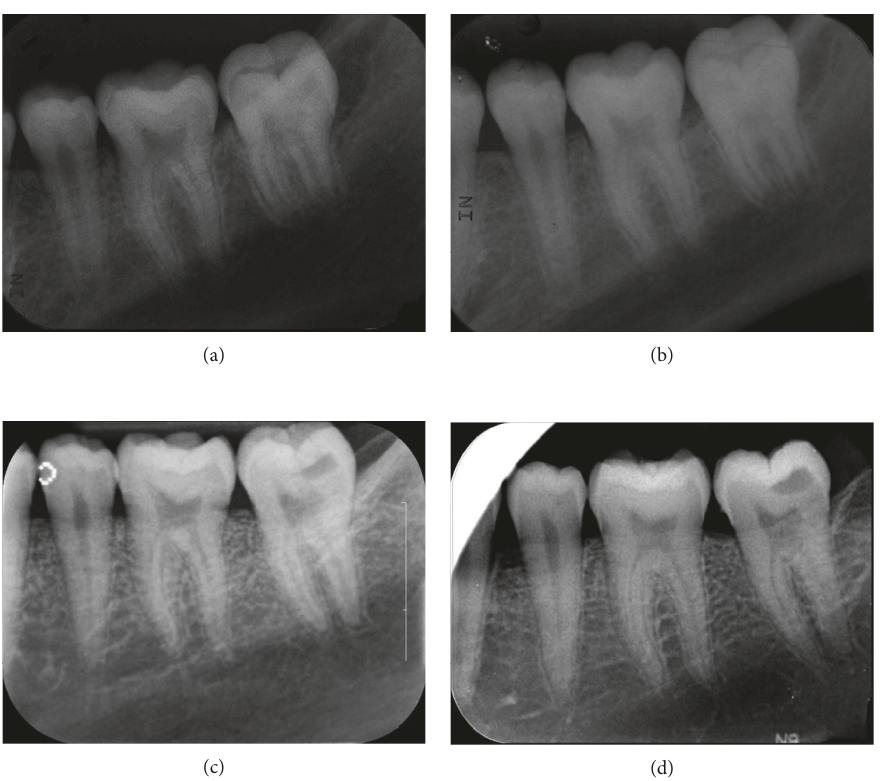
Figure 2: Periapical radiographs of the PEIR-affected tooth (permanent mandibular left second molar) when the patient was (a) 10 years, 11 months old, (b) 11 years, 5 months old, (c) 15 years, 3 months old, and (d) 17 years, 4 months old. The tooth is in the normal path of eruption, has normal crown formation, and has had continuing root formation since the first radiograph.